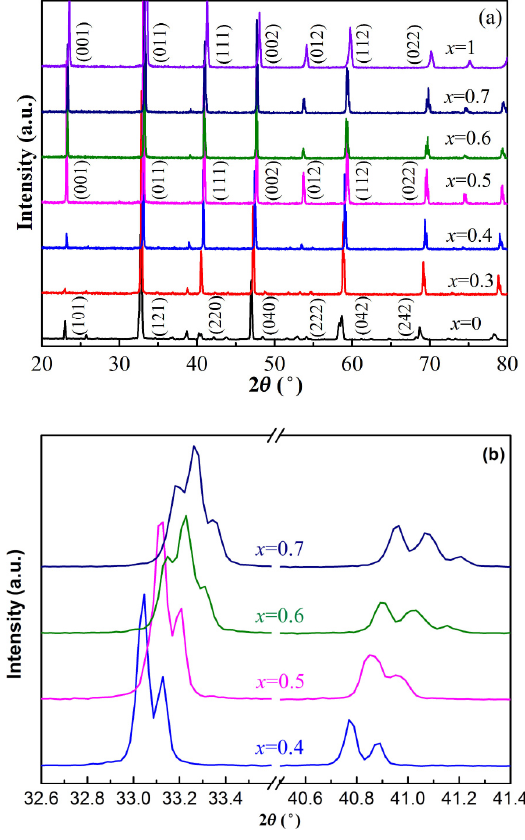
Fig. 1 XRD patterns of the CTLA ceramics sintered at 1450 ℃ for 4 h. (a) XRD patterns of the CTLA ceramics ( x = 0, 0.3, 0.4, 0.5, 0.6, 0.7, 1); (b) magnified peaks of the CTLA ceramics ( x = 0.4, 0.5, 0.6, 0.7) at 33° and 40.8°.